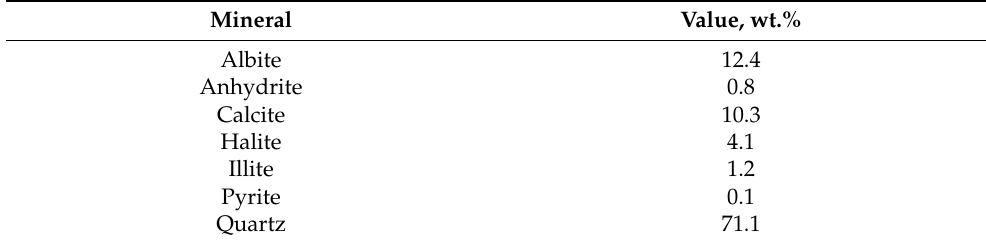
Table 2. Averaged mineralogical composition of the core for laboratory